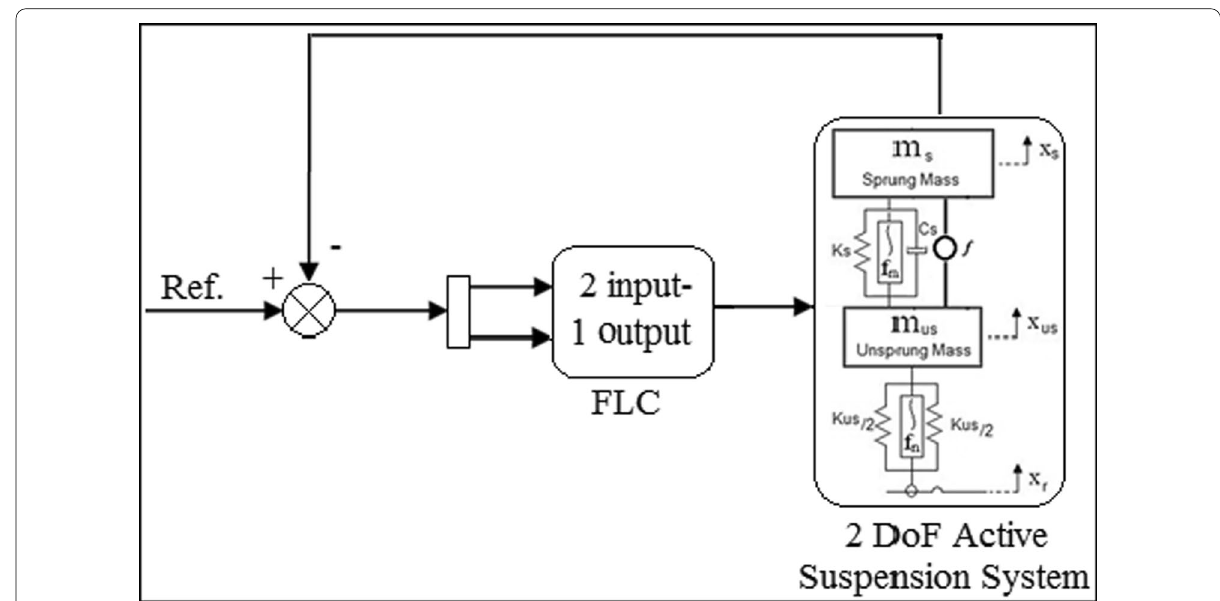
Fig. 2 Fuzzy logic controller [24]